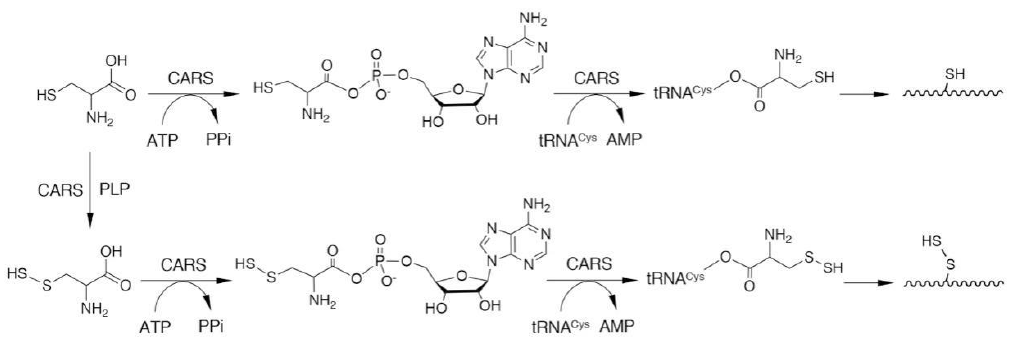
Figure 2. Enzymatic production of cysteine persulfides (CysSSHs). CBS, cystathionine β -synthase; CSE, cystathionine γ -lyase; CARS, cysteinyl-tRNA synthetase. Cofactors heme and pyridoxal phosphate (PLP) are also indicated.